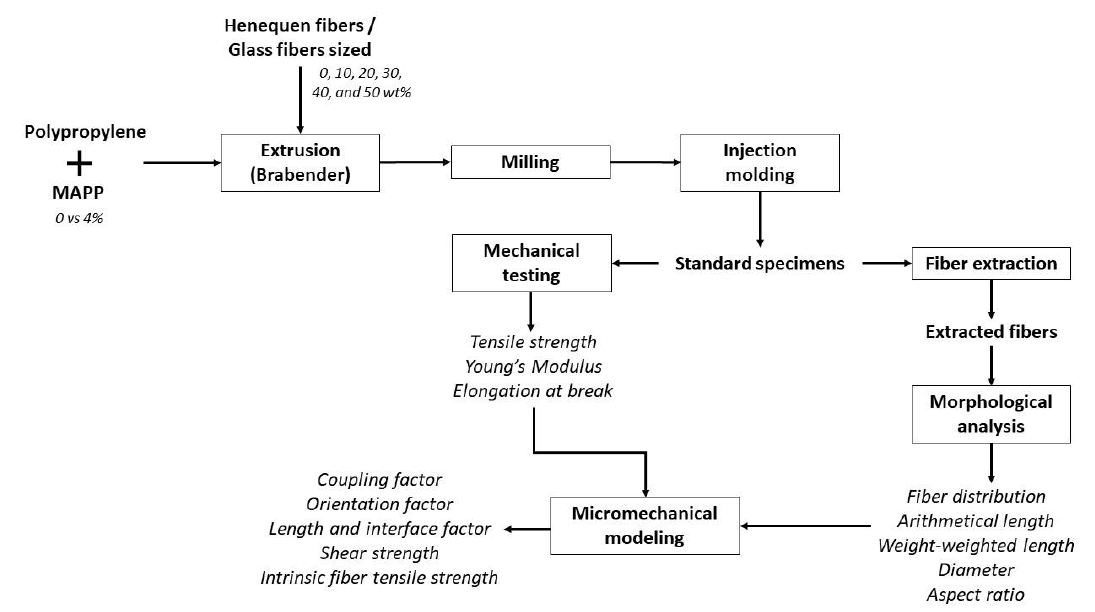
Figure 1. Chart-flow of composites preparation and characterization.